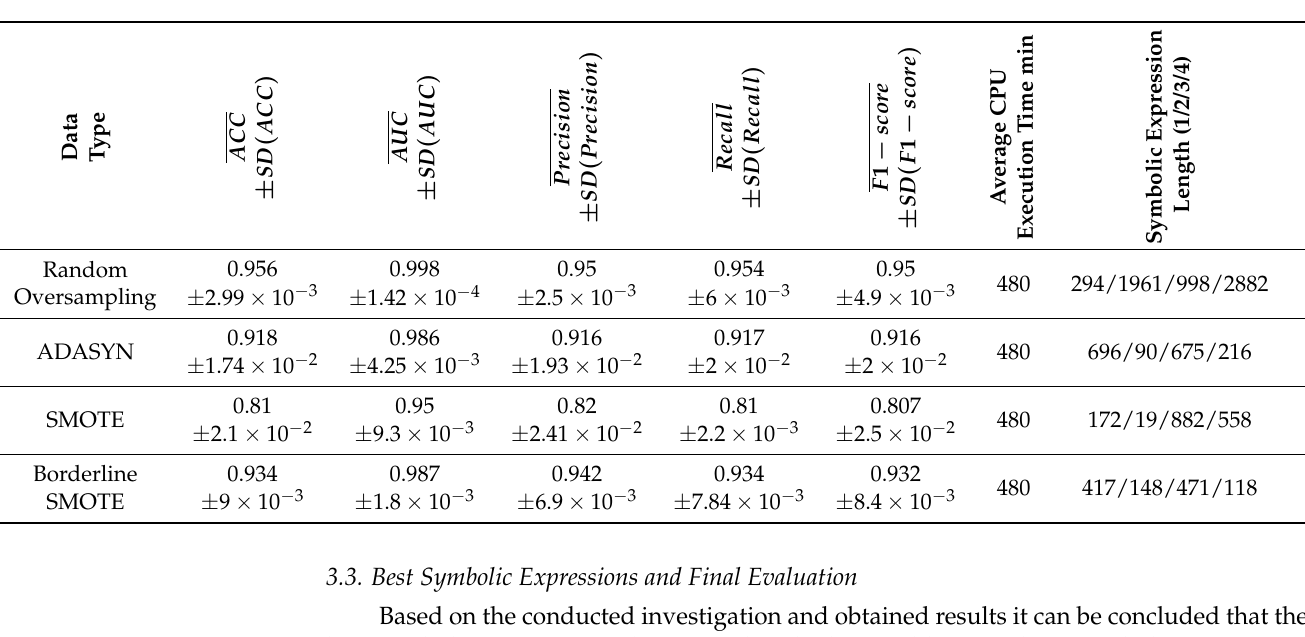
Table 6. The numerical values of mean ACC, AUC, Precision, Recall, and F1-Score with standard